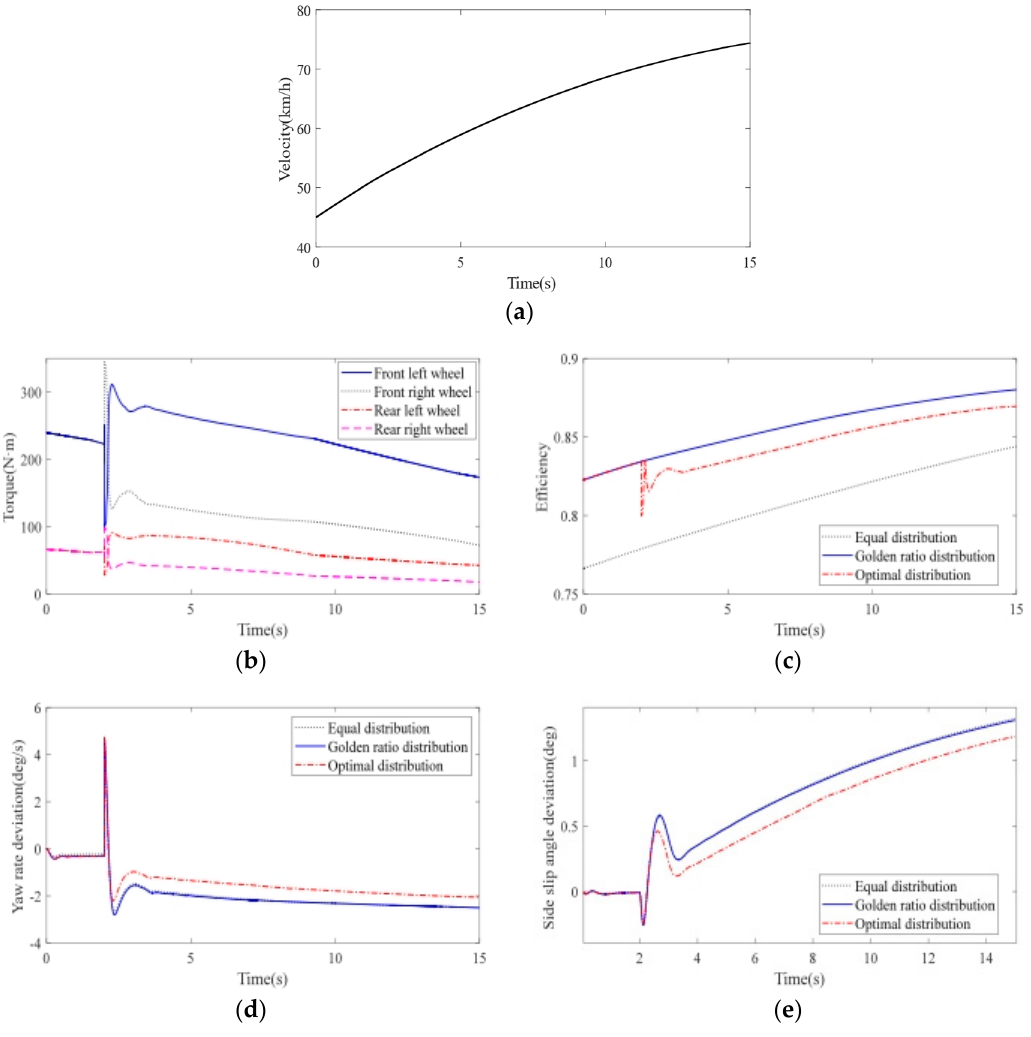
Figure 5. Simulation results of the step steering conditions: ( a ) Vx ; ( b ) optimized motor torque after distribution; ( c ) efficiency; ( d ) yaw rate deviation; ( e ) slip angle deviation.